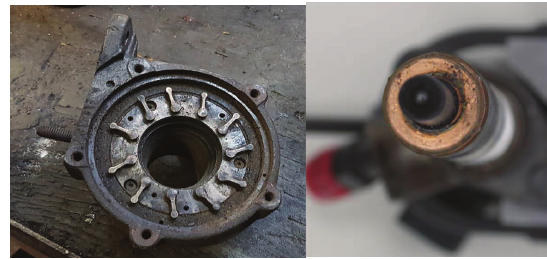
Fig. 7. Residual sediments in the area of the levers positioning the exhaust nozzle blades and in the zone of injector outer